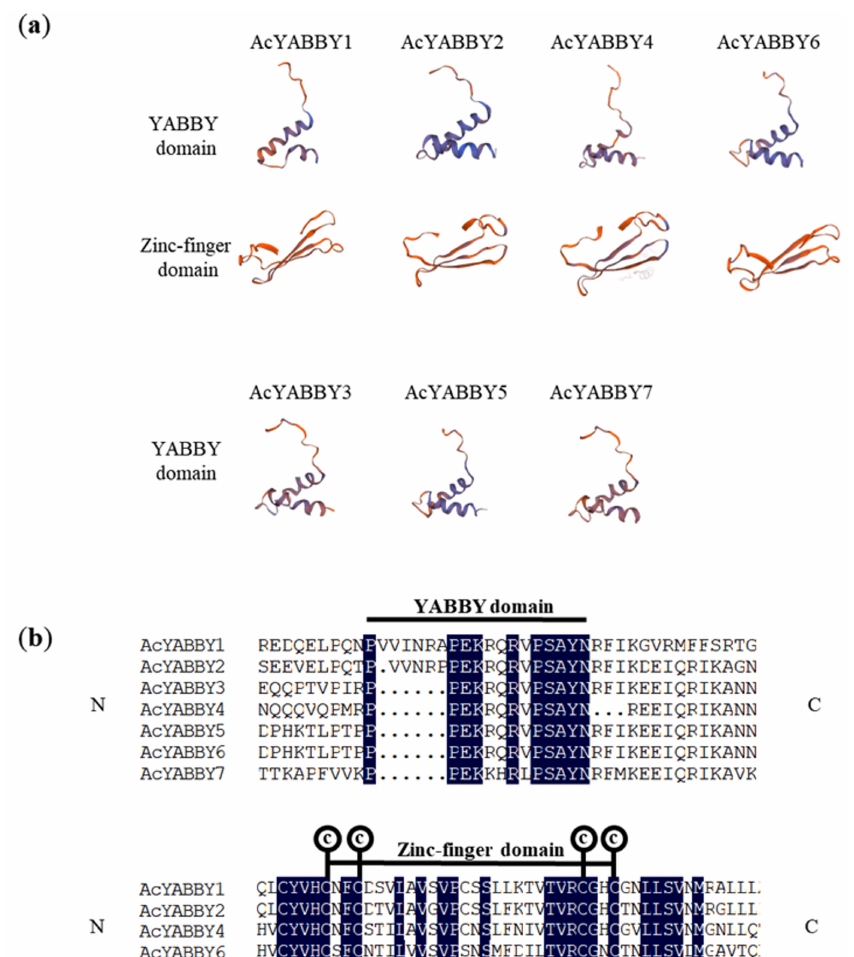
Figure 4. Predicated structures and multiple sequence alignment of pineapple YABBY proteins. ( a ) Predicted protein structures of AcYABBY proteins. ( b ) Multiple sequence alignment of AcYABBYs, zinc-finger domain and YABBY domain amino. (cid:48) N (cid:48) and (cid:48) C (cid:48) indicate the N-terminal and C-terminal. The four cysteine residues putatively responsible of the zinc-finger structure are also indicated. Identical amino acids are highlighted in